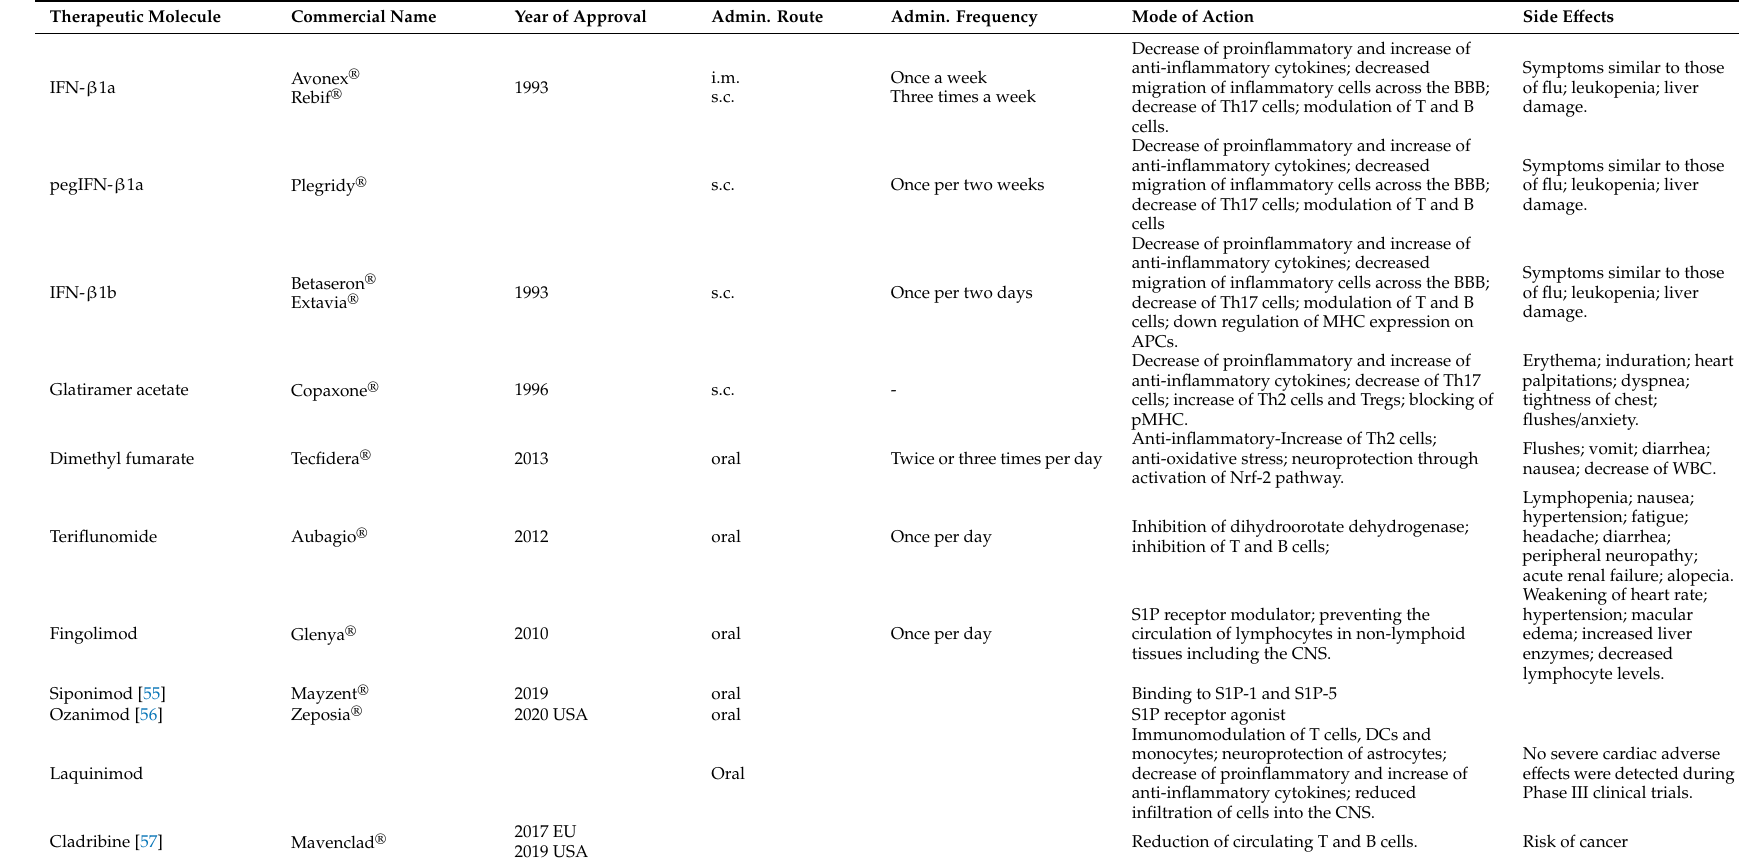
Table 1. Disease-modifying-therapies for RRMS (based on